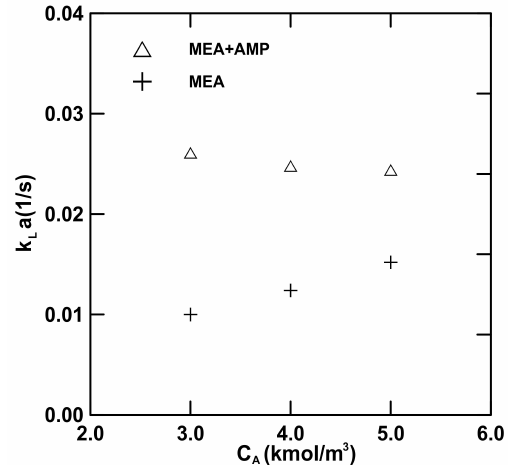
Figure 7. Effects of solvent and concentration on k L